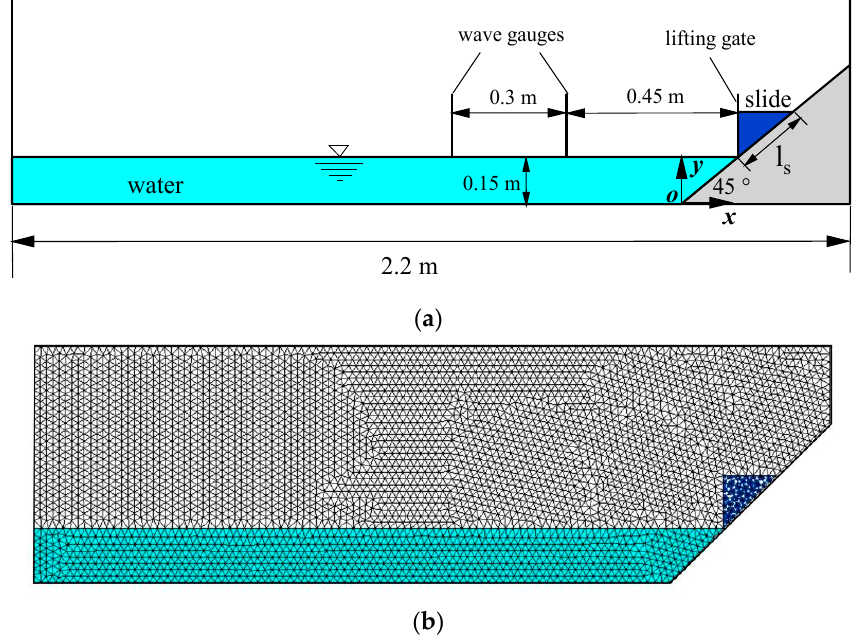
Figure 6. Calculation model for wave generation from dry granules into water along a slope: ( a ) Diagram of the initial form; ( b ) MPM discretization.